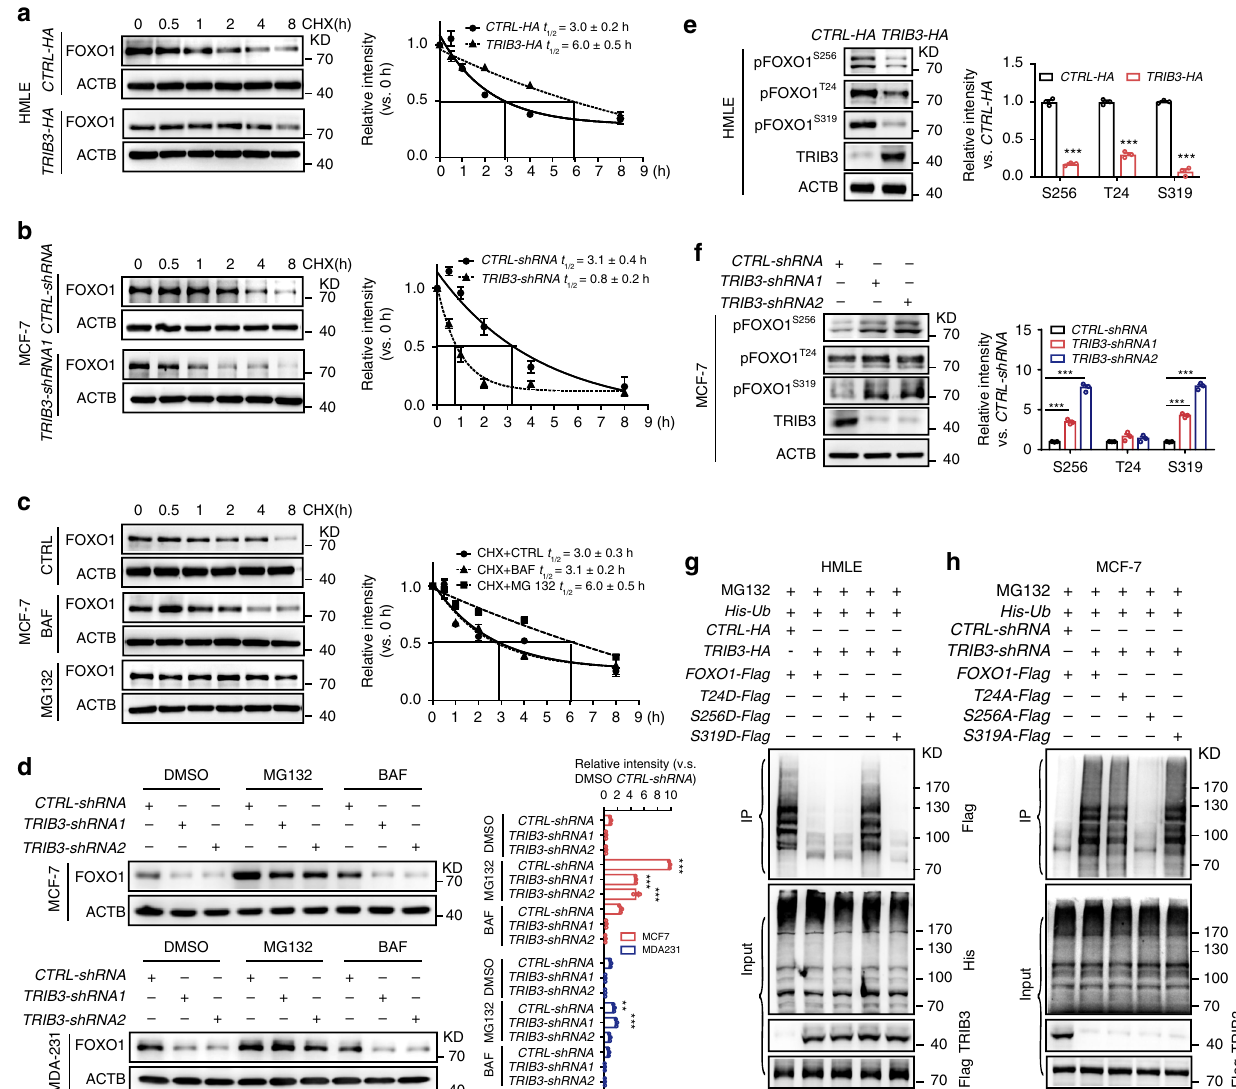
Fig. 5 TRIB3 stabilizes the FOXO1 protein by suppressing its ubiquitination. a , b HMLE cells transfected with a TRIB3 -expressing vector vs. a control vector ( a ) or MCF7 cells transfected with TRIB3-shRNA vs. CTRL-shRNA ( b ) were incubated with 20 μ M cycloheximide (CHX) for the indicated times. c , d The effect of TRIB3 depletion on FOXO1 degradation in vitro. MCF7 cells ( c ) were incubated with CHX (20 μ M), CHX plus ba fi lomycin (BAF, 200 nM), or MG132 (10 μ M) for the indicated times. Control or TRIB3-silenced MCF7 cells ( d , top) and MDA-MB-231 cells ( d , bottom) were incubated with DMSO, 200 nM BAF, or 10 μ M MG132 for 8 h. The indicated proteins were detected by immunoblotting. e , f FOXO1 activity in HMLE cells ( e ) transfected with a control vector or a TRIB3-expressing vector, or in MCF7 cells ( f ) transfected with CTRL-shRNA or TRIB3-shRNA and either a control vector or a FOXO1- expressing vector. g , h The effect of TRIB3 on FOXO1 ubiquitination. HMLE ( g ) or MCF7 cells ( h ) were transfected with the indicated plasmid. His- ubiquitin-conjugated proteins were pulled down from cell lysates. Total protein lysates and Ni-NTA-agarose eluates were immunoblotted for FLAG, His, and TRIB3. Source data are provided as a Source Data fi TRIB3 suppressed FOXO1 ubiquitination but did not reduce the ubiquitination of the S256D FOXO1 mutant in HMLE cells (Fig. 5g). Silencing TRIB3 enhanced FOXO1 ubiquitination but not S256A-mutated FOXO1 ubiquitination in MCF7 cells (Fig. 5h). These data suggest that phosphorylation of FOXO1 at S256 is a key signal for FOXO1 ubiquitination and degradation. To determine how TRIB3 stabilized FOXO1 protein in BCCs, we analyzed the microarray transcriptome of TRIB3-silenced MCF7 cells. The expression of 91 FOXO-related E3 ligase genes only E3 ligase whose expression can be reduced by TRIB3. We was identi fi ed by TRIB3 silencing and CBLL1 , NEDD4L , UBE3C , found that NEDD4L interacted with the FOXO1 C terminus and and SKP2 were signi fi cantly elevated (Supplementary Fig. 5a). Silencing TRIB3 enhanced protein expression of NEDD4L but not UBE3C, CBLL1, or SKP2 (Supplementary Fig. 5b). Silencing HMLE cells (Supplementary Fig. 6c). K463 was the key site at